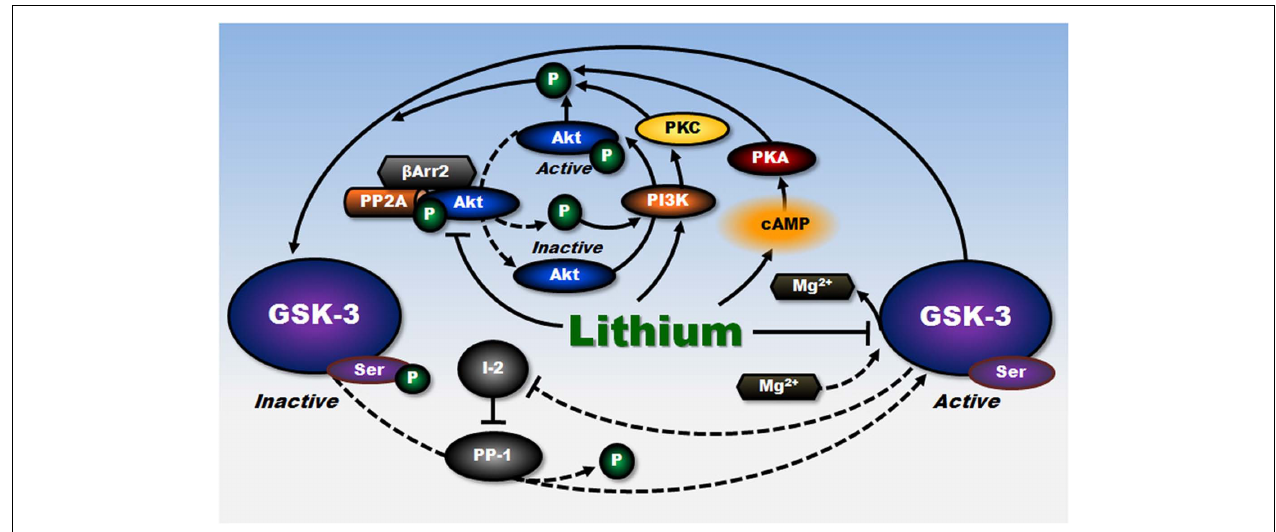
( β Arr2)–PP2A–Akt complex that dephosphorylates and inactivates Akt. In addition, by disinhibiting the inhibitory action of inhibitor-2 (I-2) on protein phosphatase-l (PP-1) that dephosphorylates GSK-3 at serine residues, lithium’s direct inhibition of GSK-3 interrupts this auto-regulation of GSK-3 and further decreases GSK-3 activity. Lines with solid arrows represent stimulatory connections; lines with flattened ends represent inhibitory connections. Dashed lines represent pathways with reduced activity as a result of lithium treatment. I-2, inhibitor-2; PP-1, protein phosphatase-l. (Modified from Chiu and Chuang,